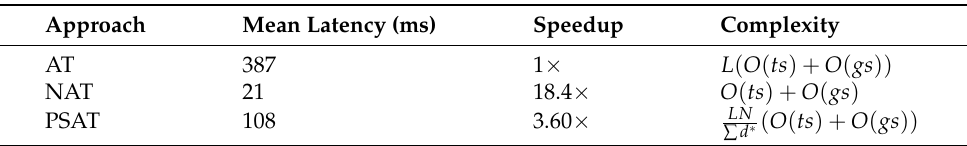
Table 3. Comparison of mean latency, speedup, complexity in AT, NAT and PSAT on RWTH-